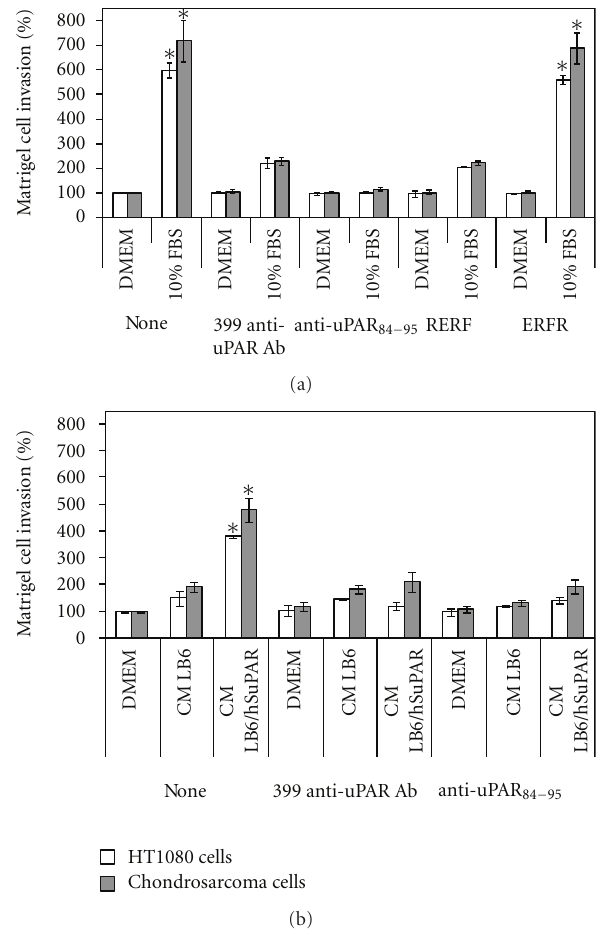
Figure 5: uPAR-dependent matrigel invasion of chondrosarcoma. Cells human fibrosarcoma HT1080 and chondrosarcoma cells were subjected to cell invasion assays. Cells were preincubated with DMEM (none), 2 μ g/mL indicated anti-uPAR antibodies, 10nM RERF peptide or 10 nM ERFR peptide, plated in Boy- den chambers and allowed to cross matrigel-coated filters for 18h at 37 ◦ C in humidified air with 5% CO 2 . 10% FBS (a), LB6, or LB6/hSuPAR conditioned media (b) were employed as chemoattractants. In all cases, data are reported as a percentage of invading cells in the absence of chemoattractant, considered as 100% (DMEM), and represent the average of two experi- ments, performed in duplicate. Columns, mean of two indepen- dent experiments; bars, ± SD, ∗ P < . 001 against the control